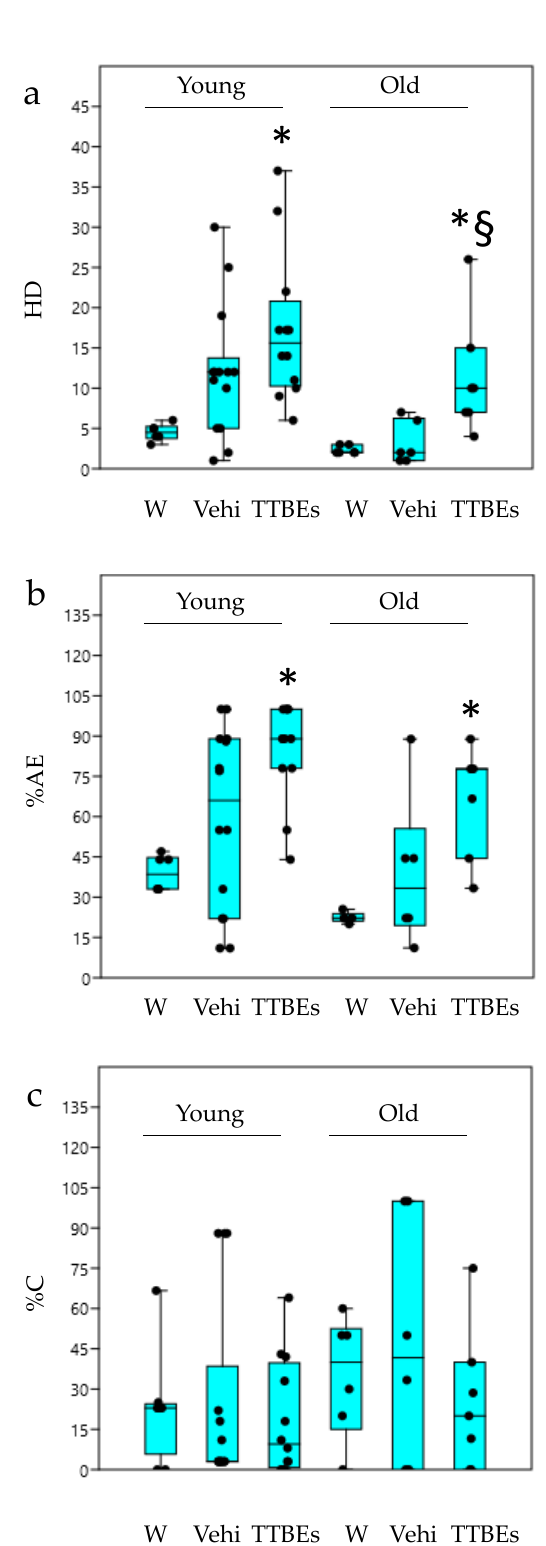
Figure 6. Hole Board test in young and old male mice: e ff ects 21 days of dietary integration with vehicle, TTBEs respect to water. Behavioral skills were quantified as ( a ) n ◦ head dippings (%HD), ( b ) % of area explored (%AE), ( c ) % of entries into center (%C). Data represent the mean ± S.E.M. ( n = 6 (W), 14 (Vehi) 12 (TTTBEs) young and ( n = 6 (W), 6 (Vehi) 6 (TTTBEs) old mice analyzed in three di ff erent trials. Statistical analysis was performed by applying ANOVA followed by the Tukey’s multiple comparison test. * p < 0.05; p < 0.01 vs. water; § p < 0.05 vs.